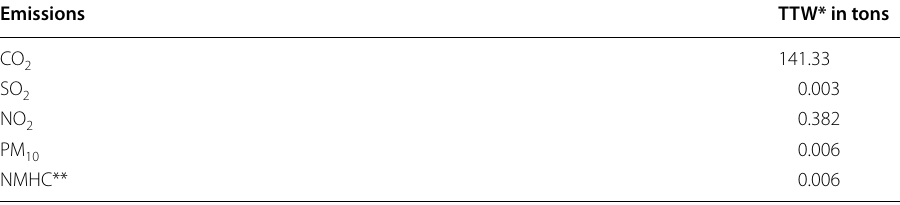
Table 7 Truck emissions in LA/LB port (drayage per containership). Source : EcoTransIT World